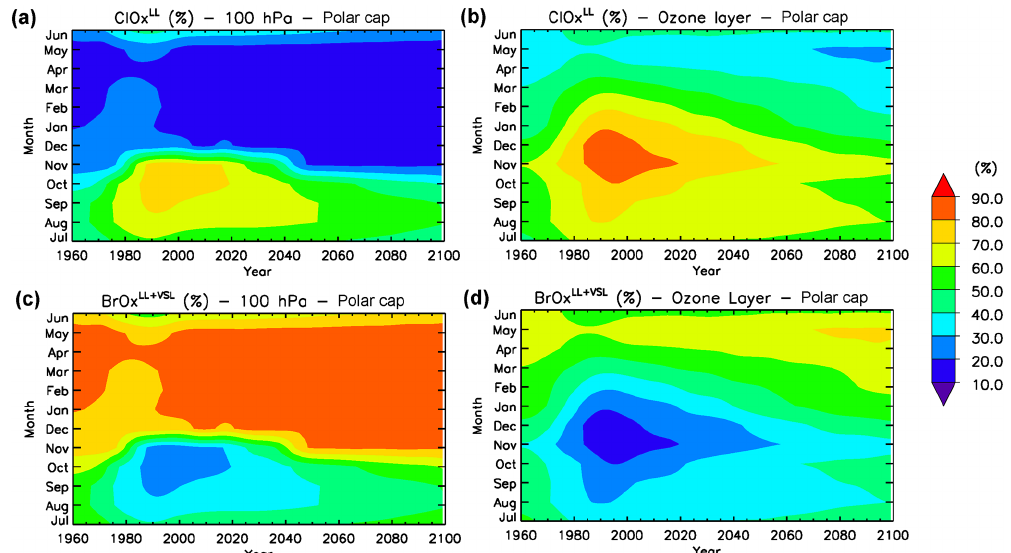
Figure 11. Evolution of the halogen-catalysed odd-oxygen loss rates as a function of the year and month for the ClO LL x family (top row) and the BrO LL + VSL x family (bottom row). The left column shows loss rate values at 100hPa ( ∼ 15km), while in the right column the loss rates were vertically integrated within the lower stratosphere (i.e. in-between the white lines shown in Fig. 10). Results are for the run LL + VSL